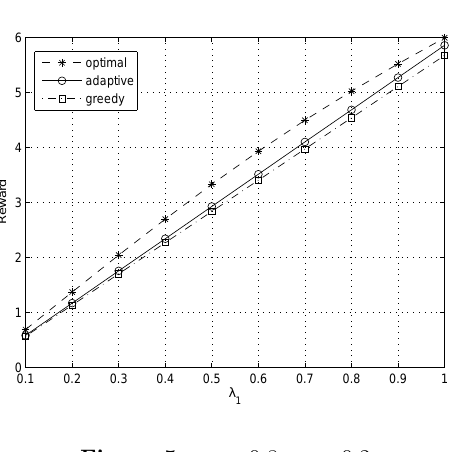
Figure 5: p 1 = 0 : 8 ; p 0 = 0 :